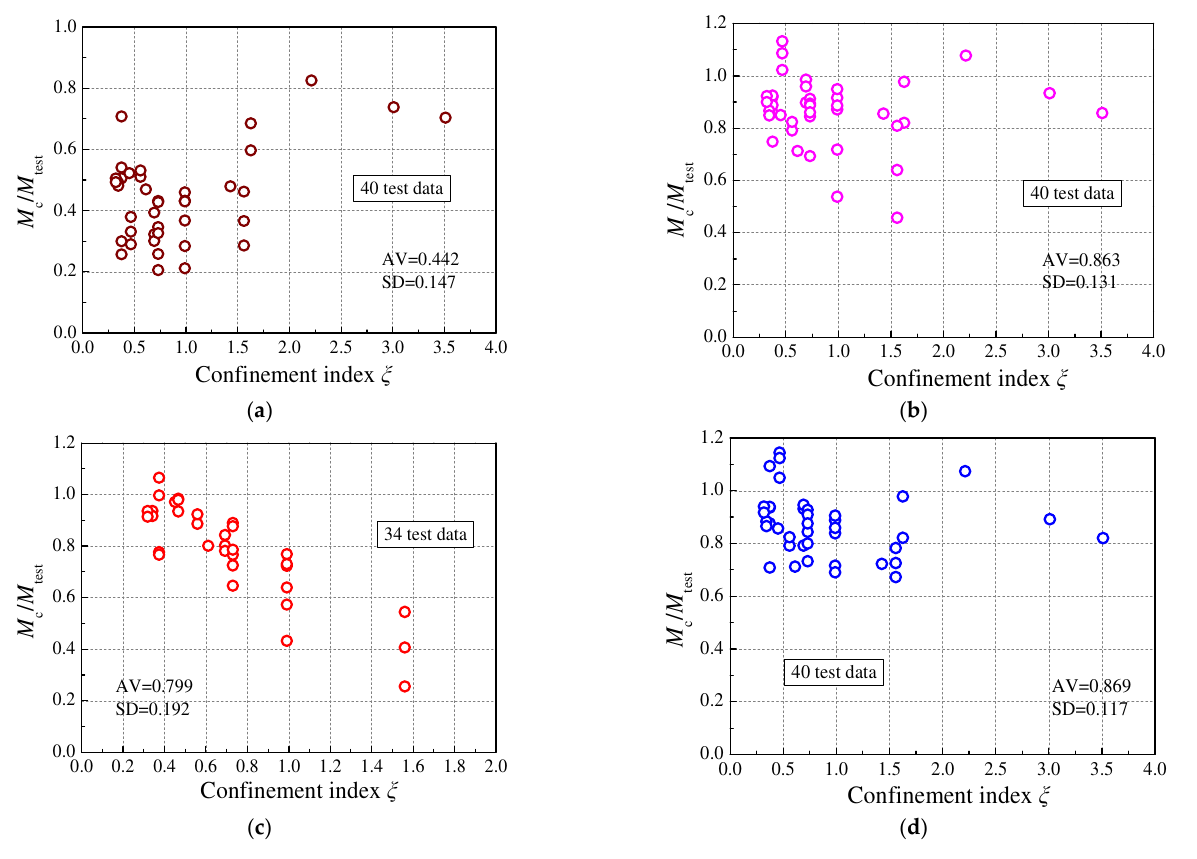
Figure 12. The comparisons of moment bearing capacities calculated by different design codes with test results. ( a ) AISC-LRFD ( b ) EC4 ( c ) GB50936 ( d ) AIJ. test results. ( a ) AISC-LRFD ( b ) EC4 ( c ) GB50936 ( d )